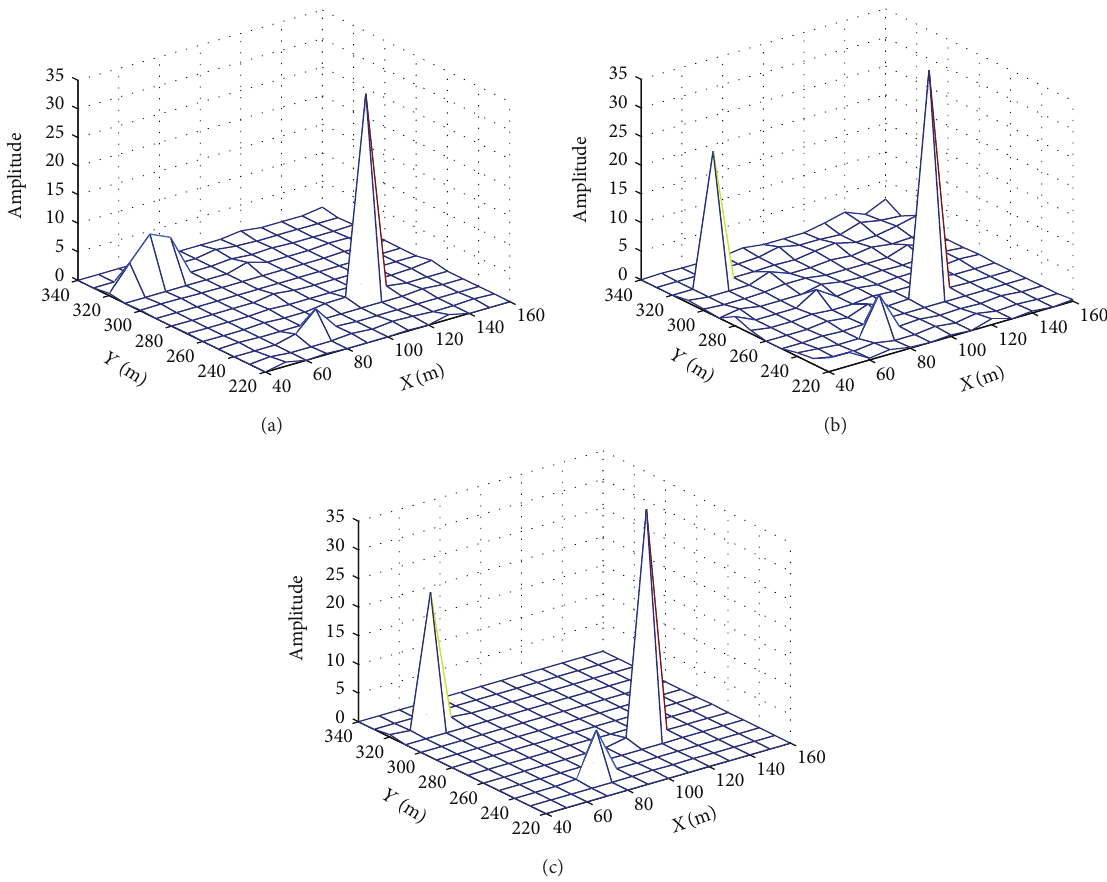
Figure 3: Comparison of reconstructed target reflection coefficients. SNR = 10dB, grid distance is 10m. (a) Group-Lasso, (b) Group-MP, and (c) BSBL- ℓ 1 exploiting